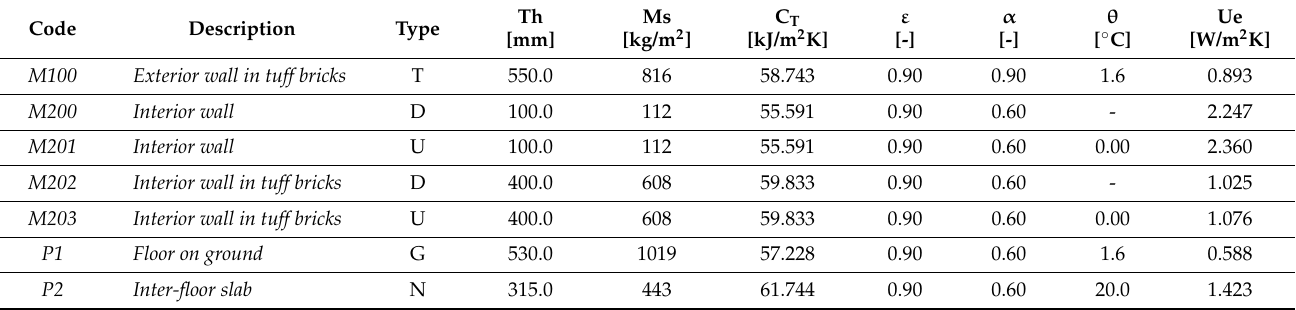
Table 2. Ante operam thermal properties of the opaque closures and internal